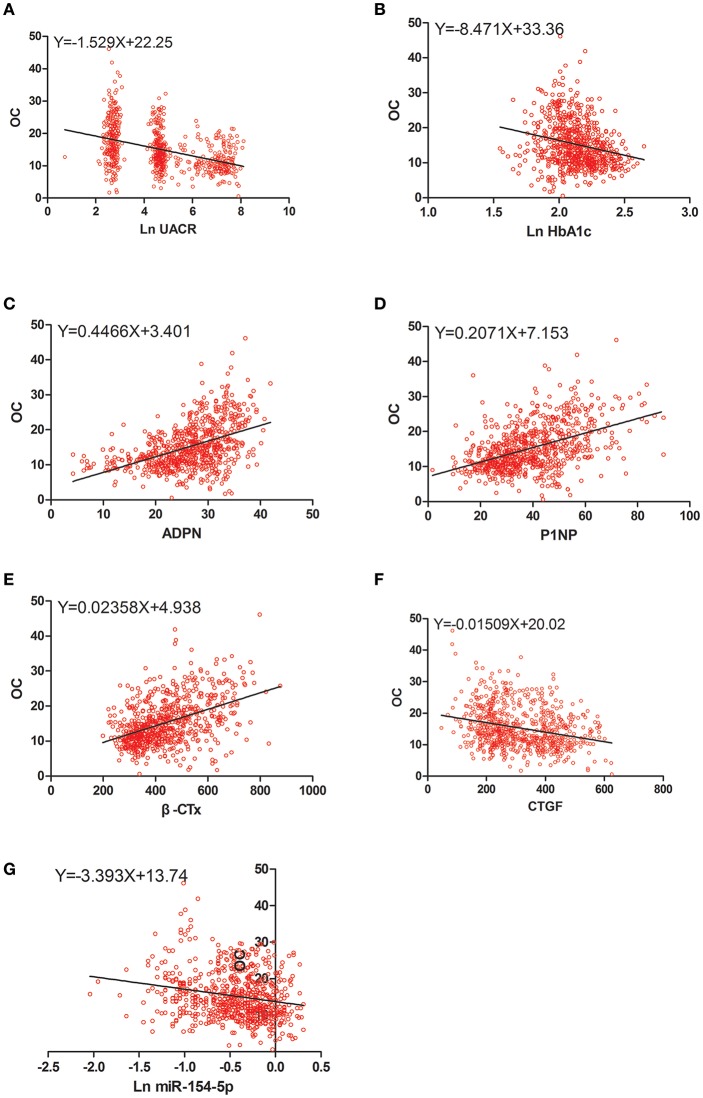
Scatter dot plots between OC and (A) Ln UACR, (B) Ln HbA1c, (C) ADPN, (D) P1NP, (E) β-CTx, (F) CTGF, (G) Ln miR-154-5p. UACR, urinary albumin excretion rate; HbA1c, glycated hemoglobin A1c; ADPN, adiponectin; P1NP, procollagen type 1 N-terminal propeptide; β-CTx, β-C-terminal telopeptide of type I collagen; CTGF, connective tissue growth factor; OC, osteocalcin.